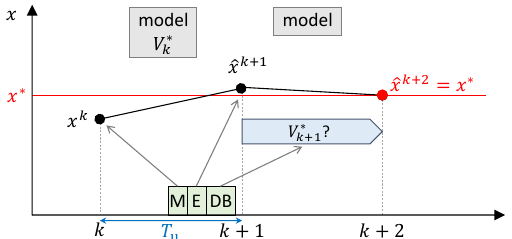
Figure 5. Working principle of DB control, visualizing the basic steps: measurement (M), estimation (E), and deadbeat voltage reference calculation